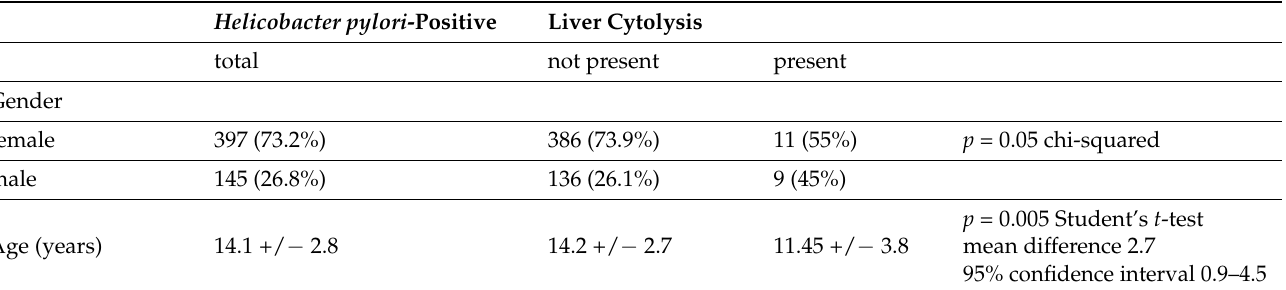
Table 5. Helicobacter pylori -positive study group structure in relation to